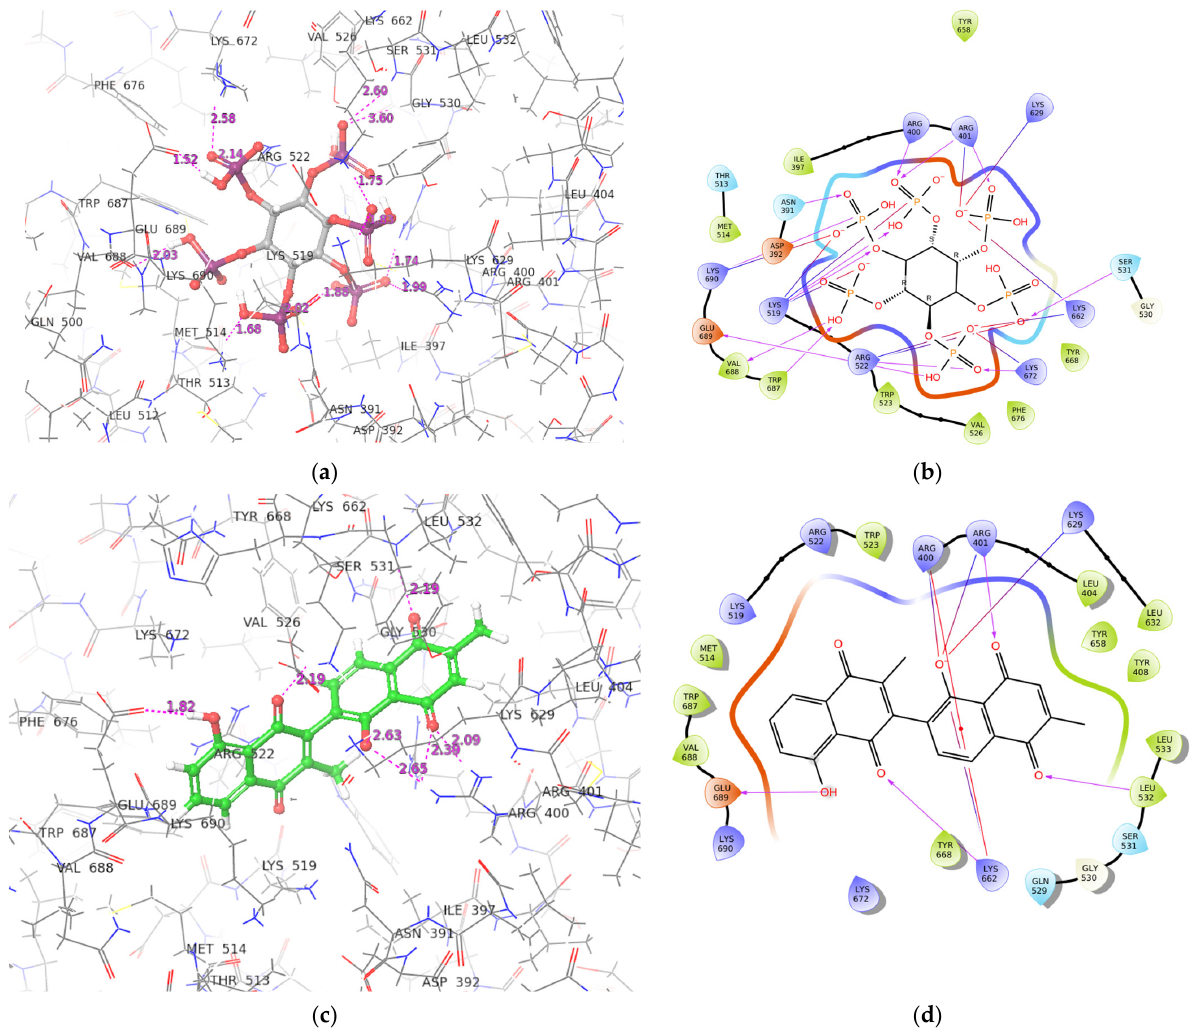
Figure 4. Conformation and protein–ligand interaction pro fi les of the binding pose with the most negative binding energy of IHP ( a , b ) and ZINC000044417732 ( c , d ). For the interaction pro fi les, purple arrows, red lines and combination of “red and blue” lines represent hydrogen bonds, pi-cation interactions and salt-brides, respectively. Table 3. Pharmacokinetic evaluation of IHP, fluoxetine, nebularine, doxorubicin, and the 9 potential lead compounds. The consensus logP value (SwissADME) is reported in this